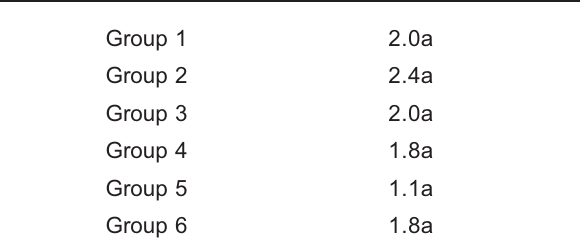
Equal letters = no statistically significant